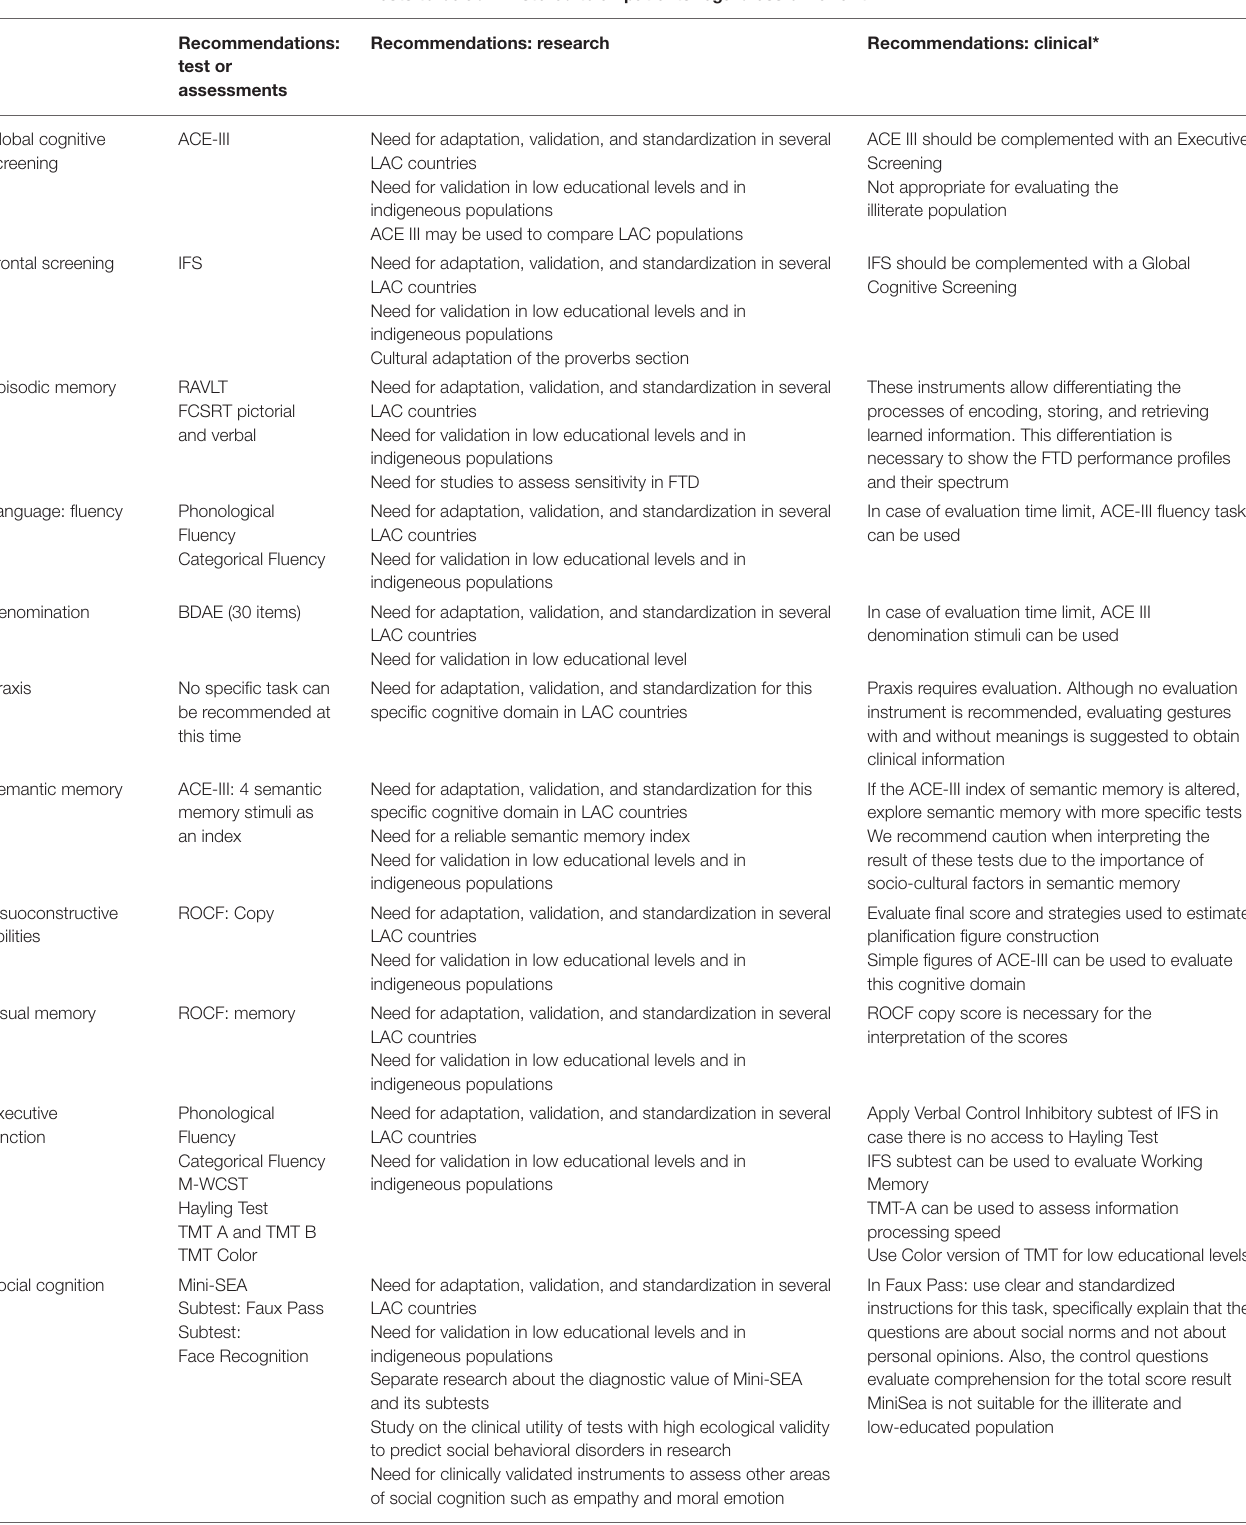
TABLE 1 | Tests to be administered to all patients regardless of